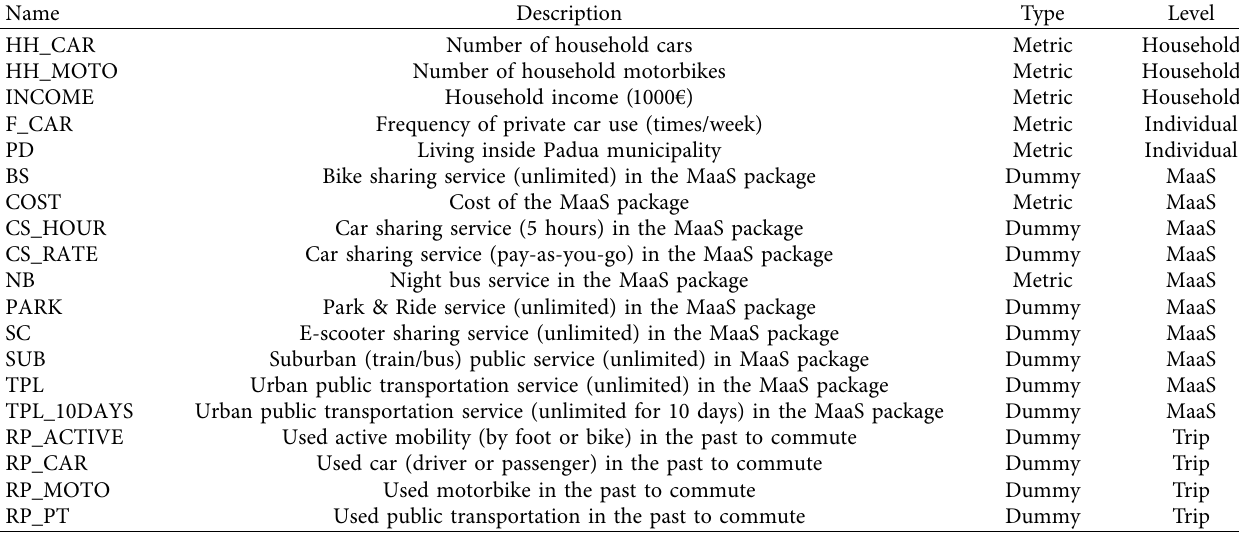
Table 2: Description of exogenous variables from the MaaS bundle choice model.